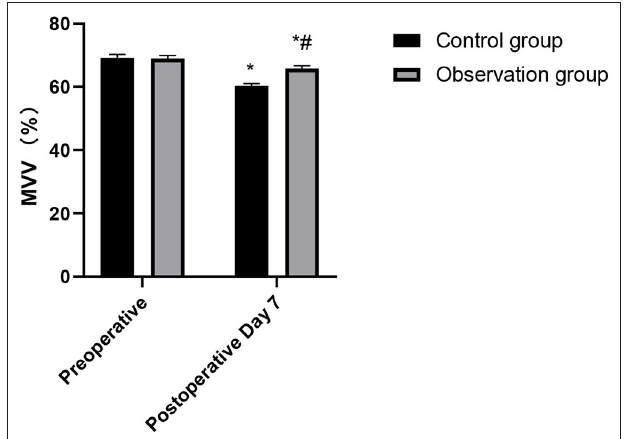
FIGURE 7 | Comparison of the incidence of adverse reactions between the two groups. Compared with the control group, * p < 0.05.